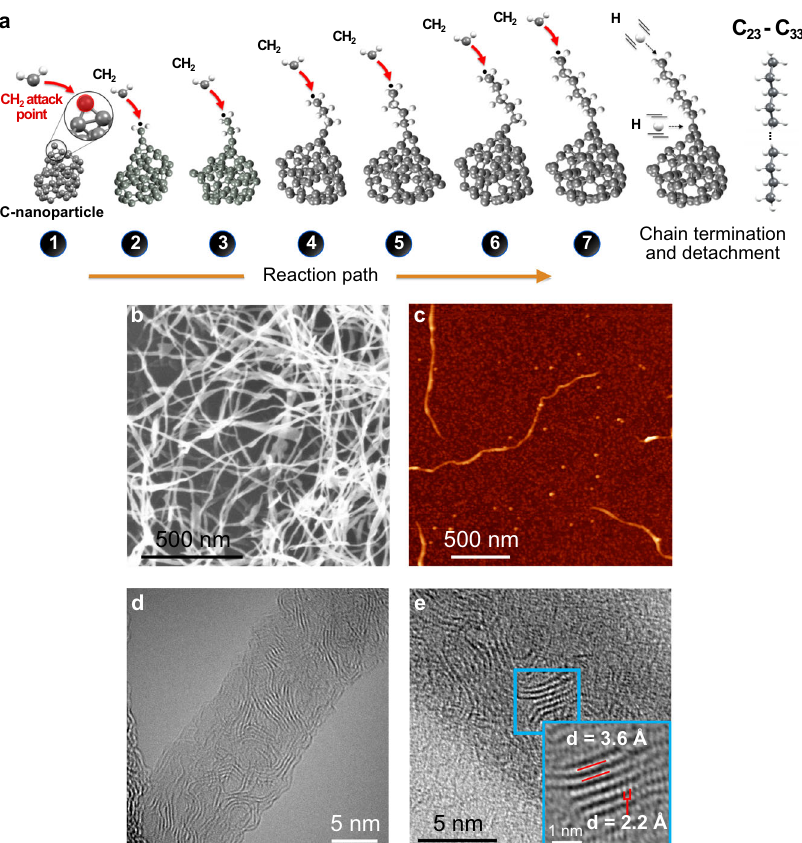
Fig. 1 General schematic of the C – C coupling mechanism leading to long fi bres. a Pictorial views of the DFT-optimised fi rst steps for the growth of an alkane on a model (random generated) amorphous C-NPs by sequential addition of CH 2 groups. b SEM image of a mat of fi bres collected on a silicon surface. c ex situ AFM image of a typical individual fi bre collected on a silicon surface. The bright spots correspond to amorphous C-NPs that are also produced (colour scale 0 nm, 30 nm). d C s -corrected HR-TEM image of an individual fi bre where locally ordered regions can be easily distinguished. e High-magni fi cation image of those